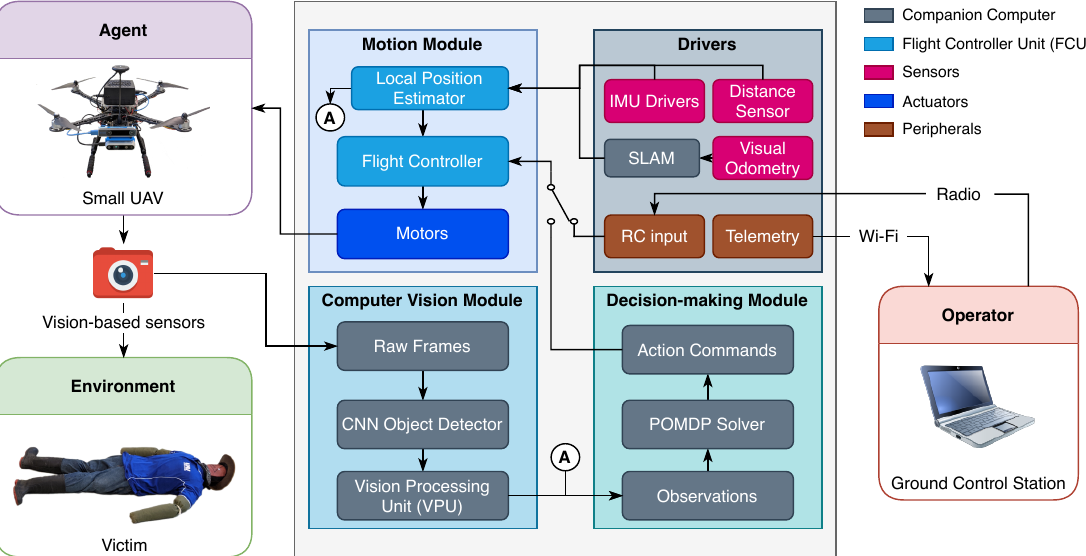
Figure 1. Proposed modular system architecture for an autonomous onboard navigation in Global Navigation Satellite System (GNSS)-denied environments in small Unmanned Aerial Vehicles